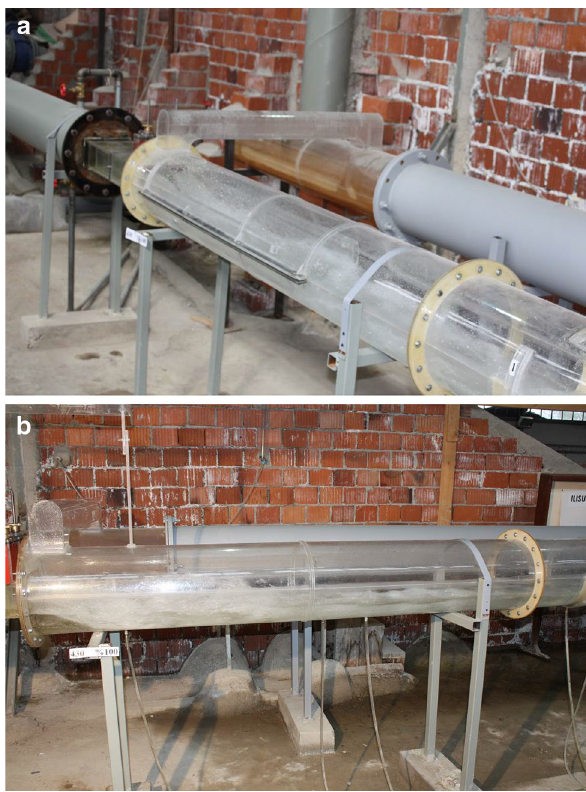
Fig. 1 A view from physical laboratory model (DSI Report 2013)